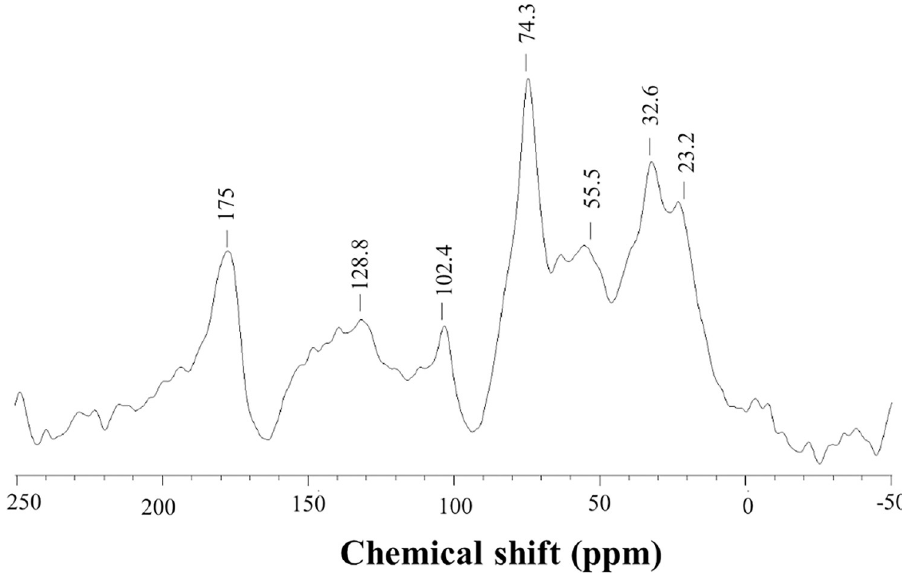
Fig 2. 13 C-CPMAS-NMR spectrum of